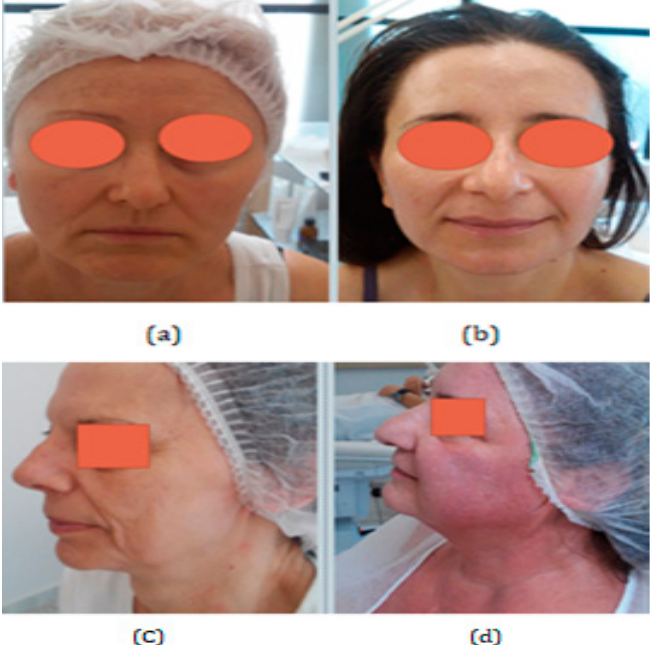
Figure 2. ( a ) Biological aging in dry skin. The subject does not smoke but lives in a city with air pollution. ( b ) Biological aging with oily skin. The subject does not smoke, lives out of the city, uses moisturizing cream daily, drinks water, and eats fruits every day. ( c ) Photoaging with dry skin. The subject does not drink water and does not eat fruits daily. She lives in the city and does not use moisturizing cream daily. ( d ) Biological aging in sensitive and oily skin. All four women have the same age (54 years old), and use sun cream daily, but have different types of skin and different ways of life, and as a result, show different characteristics of aging. (Archival material by courtesy of Dr. Foteini Biskanaki, 2019).